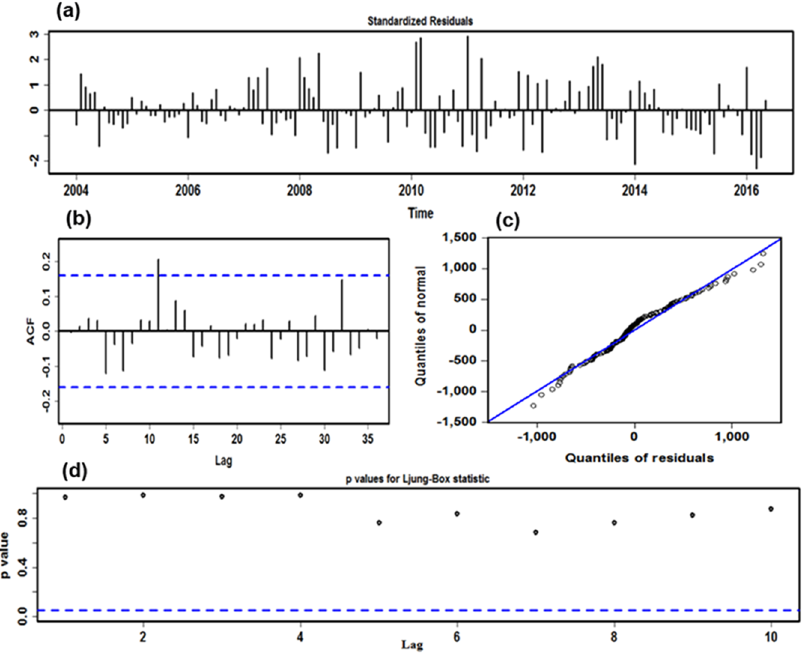
Figure 2. Residual diagnostic plots of ARIMA (1,1,1) × (0,1,1) 12 model. ( a ) Standardized residuals. ( b ) Autocorrelation function (ACF) plot of the time-series residuals. ( c ) Normal Q-Q plot for determining the normality of the time-series residuals. ( d ) P values for Ljung-Box statistic. The ACF shows that no significant residual correlations are observed in the time series at the 5% level, and P values for Ljung-Box statistic are never significant at various lags. The normal Q-Q graph of the time-series residuals approximately falls along the line. These imply the selected ARIMA method offers a reasonable simulation to the monthly human brucellosis time series.